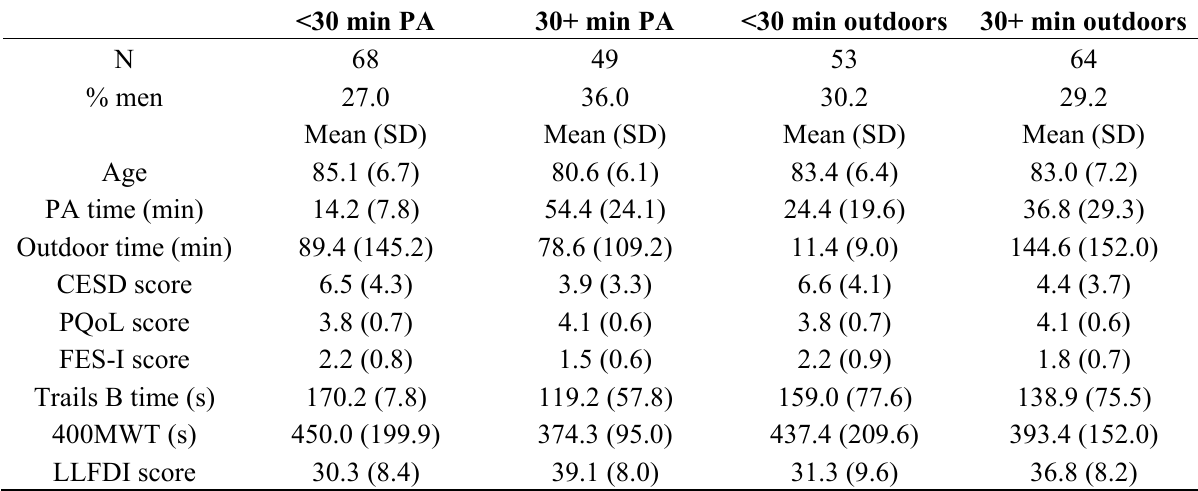
Table 1. Descriptive statistics for participants according to the two independent variables tested in the main effect